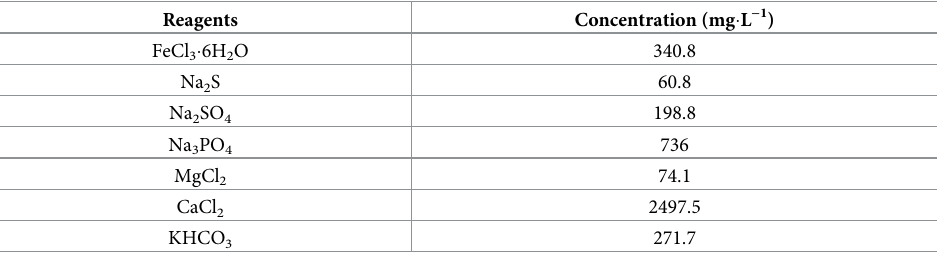
Table 1. Formulation of ionic mother